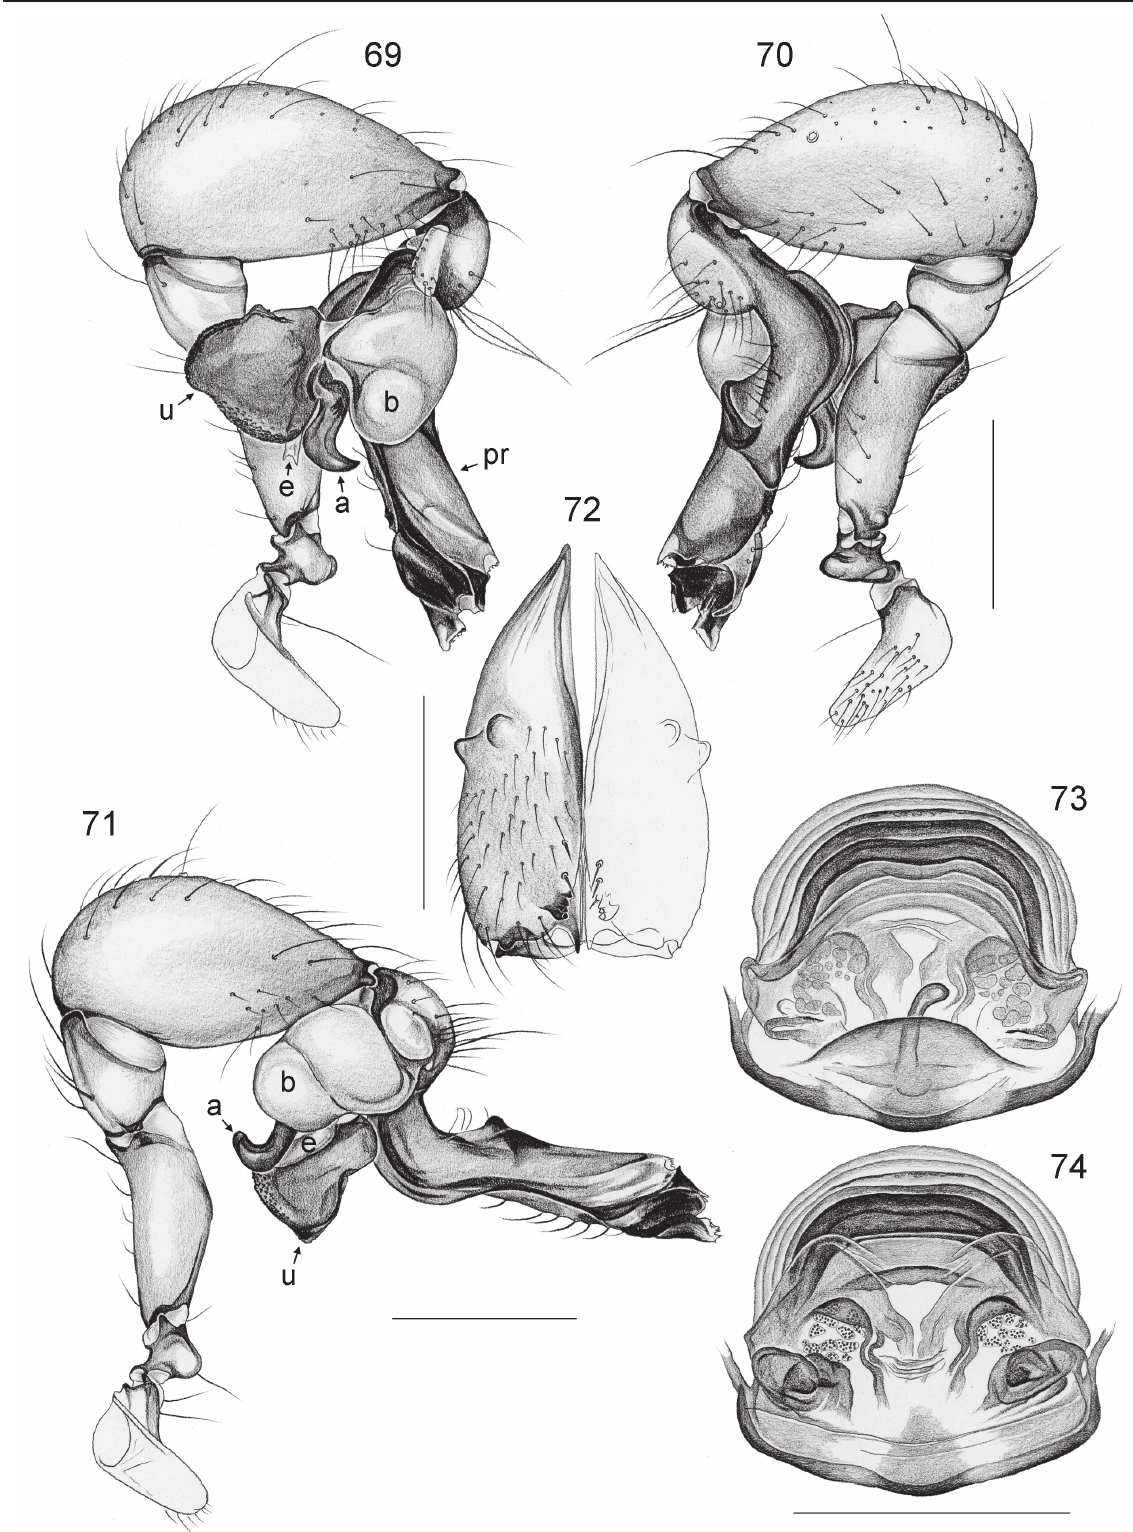
Figs 69-74. Pholcus punu sp. nov. 69-70 . Left ♂ palp, prolateral and retrolateral views. 71 . extended palp with rotated bulb. 72 . ♂ chelicerae, frontal view. 73-74 . Cleared ♀ genitalia, ventral and dorsal views. a = appendix; b = bulb; e = embolus; pr = procursus; u = uncus. Scale lines: 69-71, 73-74 = 0.5 mm; 72 = 0.3